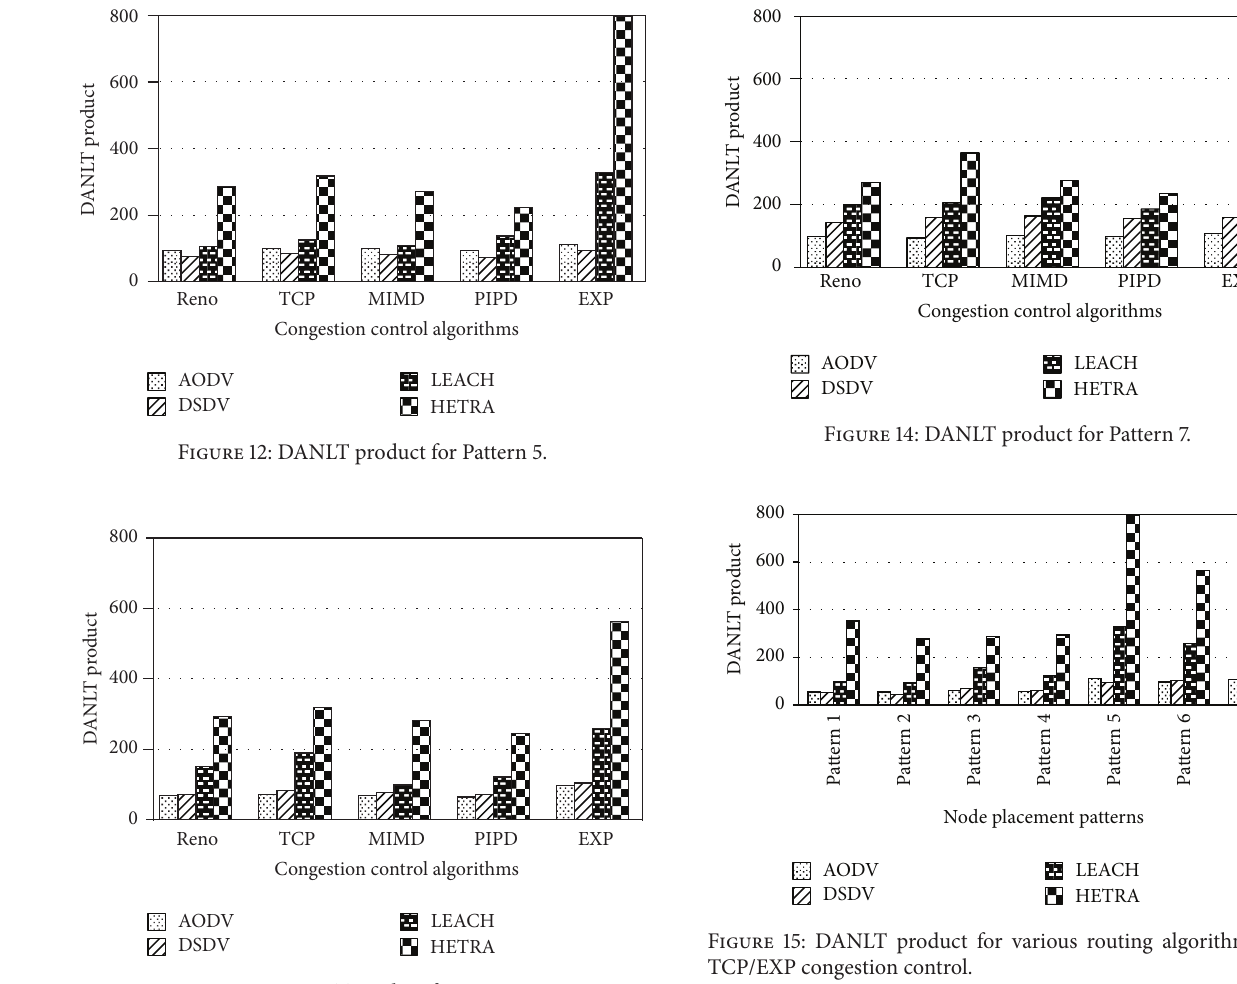
Figure 13: DANLT product for Pattern 6.